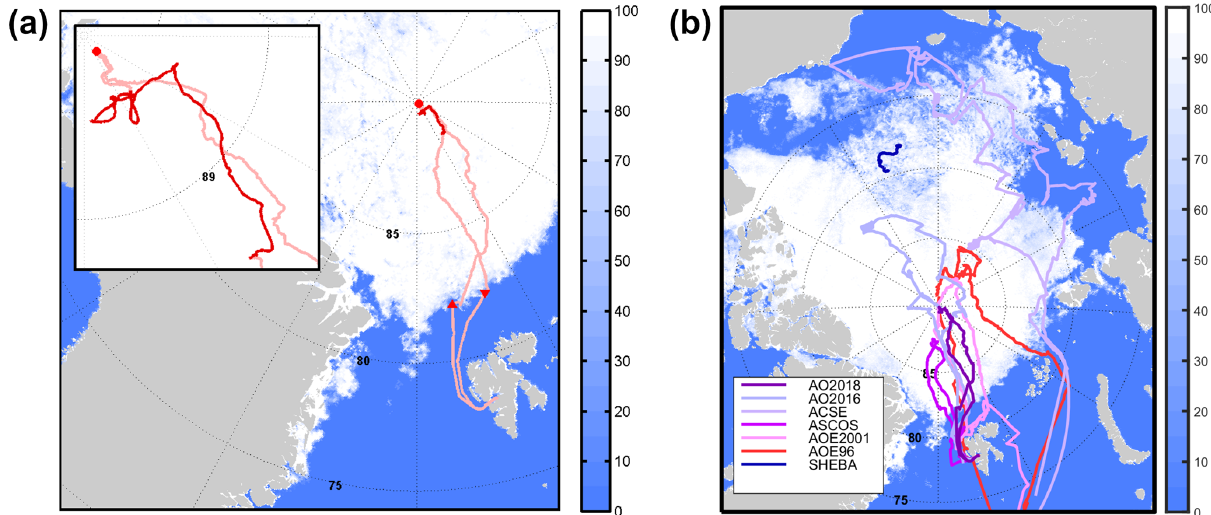
Figure 1. (a) AO2018 cruise track (pink) with the ice drift track (14 August–14 September 2018, red and inset). The measurement stations within the marginal ice zone are marked by (cid:78) (inbound, 2 August 2018) and (cid:72) (outbound, 20 September 2018), and the “North Pole” station by • (12 August 2018). Colour gradient shows ice concentration (%) for 1 September 2018, obtained from the University of Bremen satellite sea ice product (http://seaice.uni-bremen.de, last access: 4 January 2021, Spreen et al., 2008). (b) Cruise tracks of previous campaigns conducted in the Central Arctic ocean with same ice concentration as shown in panel (a)